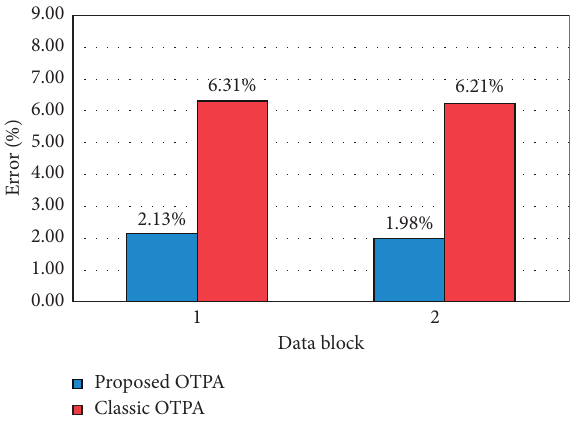
Figure 14: Errors of the proposed and classic OTPA in the response synthesis.